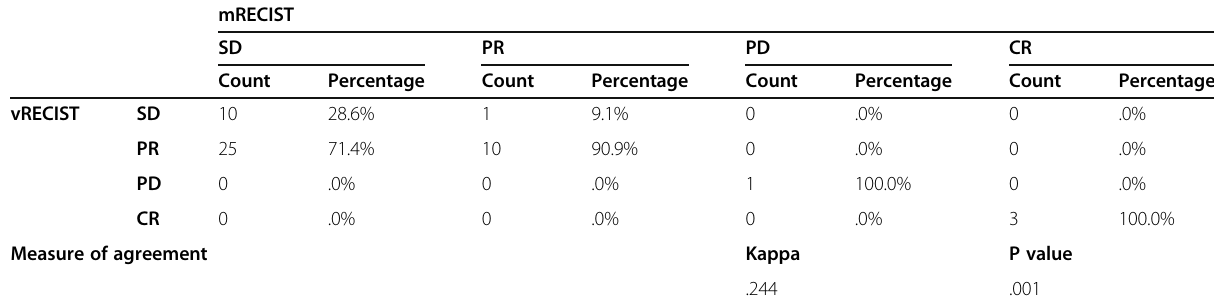
Table 4 Relation between mRECIST and vRECIST methods in assessment of the therapeutic response whether CR, PR, SD or